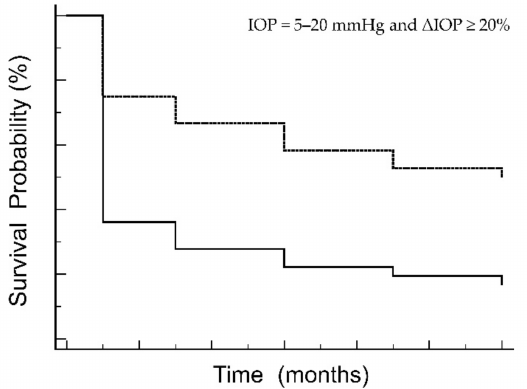
Figure 2. Kaplan–Meier survival curves for surgical success. Continuous line: complete success (IOP = 5–20 mmHg and ∆ IOP ≥ 20% without additional anti-glaucoma medications). Broken line: qualified success (IOP = 5–20 mmHg and ∆ IOP ≥ 20% with additional anti-glaucoma medications). IOP = intraocular pressure.